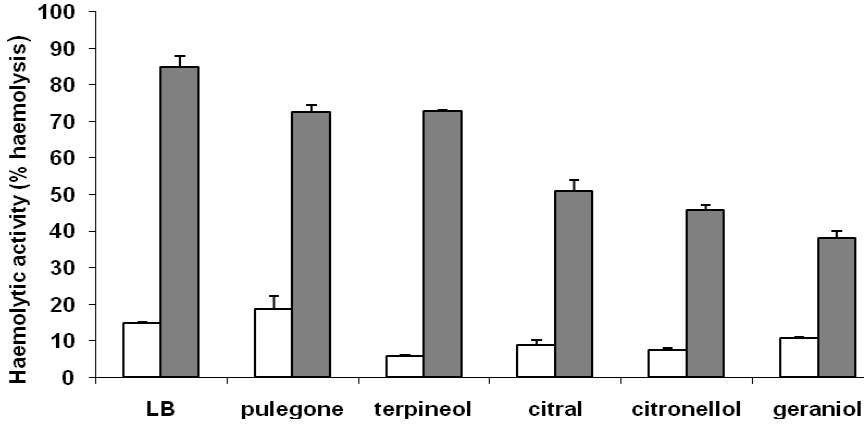
Figure 6. Effect of selected monoterpenes on the haemolysin activity of P. mirabilis L68. The concentration of monoterpenes added were 0.3 mg/L for citronellol and geraniol, and 0.5 mg/L for citral, pulegone and α -terpineol. Data represent the average of three independent experiments. Vegetative cells (white bars), Swarming cells (gray